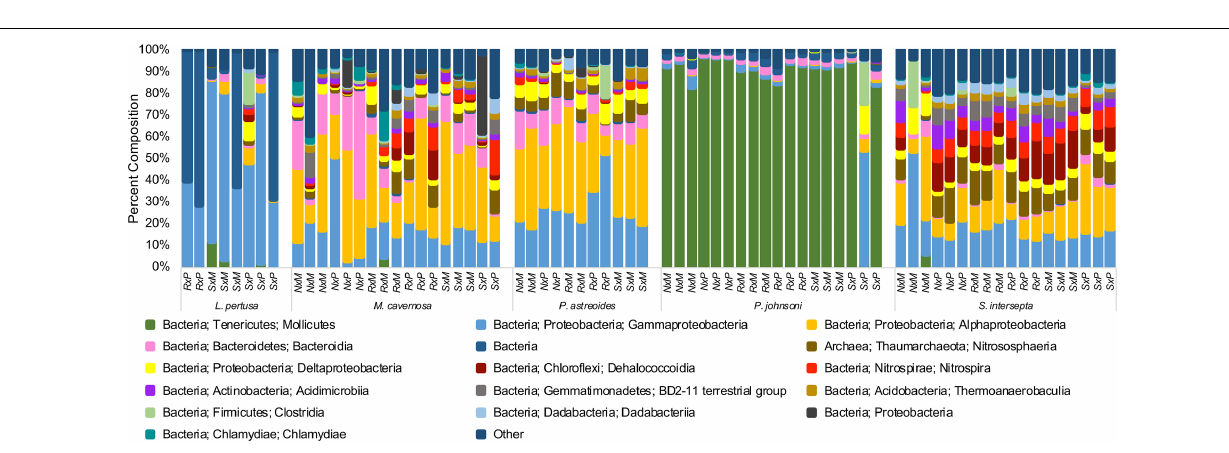
FIGURE 2 | Taxonomic composition of bacterial communities from five coral species, Lophelia pertusa, Montastraea cavernosa, Porites astreoides, Paragorgia johnsoni, and Stephanocoenia intersepta . Preservative abbreviations: R, RNAlater; S, DNA/RNA Shield; N, liquid nitrogen. Extraction method abbreviations: M, Maxwell RSC; P, PowerBiofilm. The single P. johnsoni sample not primarily composed of Mollicutes was removed as an extreme outlier in other analyses. Several groups could not be resolved to the class